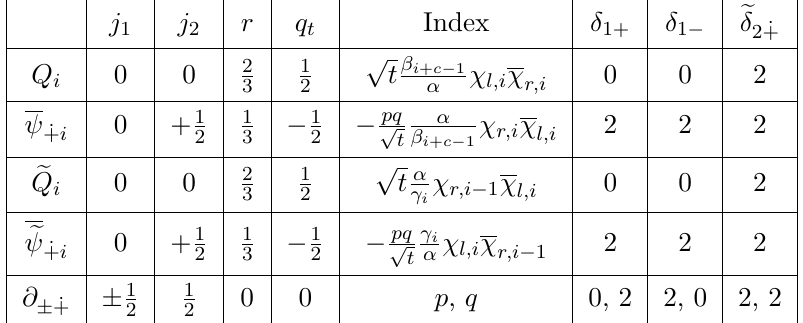
Table 4. Letters satisfying the BPS condition (4.4) for the free trinion theory associated to a sphere with one minimal puncture (with associated U(1) valued fugacity α ) and two maximal punctures and s r, + . Here χ ( z ) , χ ( z ) are shorthand for the characters s l, + ≡ χ o,i ≡ χ (1 , 0 ,..., 0) o,i o,i (0 , 0 ,..., 1) o,i c c +1